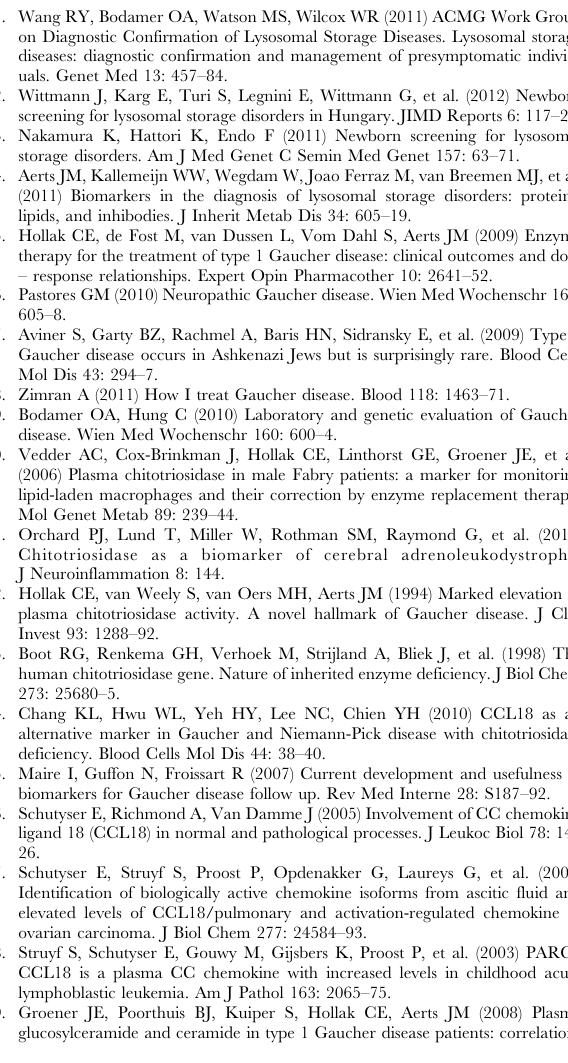
Table S1 Genotypes for all included GD patients. GBA cDNA accession number NP_000148.2; Traditional amino acid residue numbering, which excludes the first 39 aminoacids of the leader sequence, is provided and designed without the prefix ‘‘p’’. All detected genotypes are listed and have been confirmed